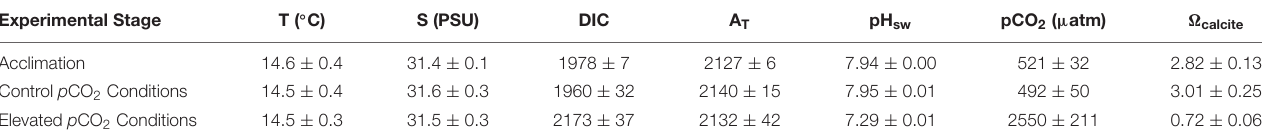
TABLE 1 | Summary of water chemistry during the 14-day acclimation period and 28-day experimental exposure. Experimental Stage T ( ◦